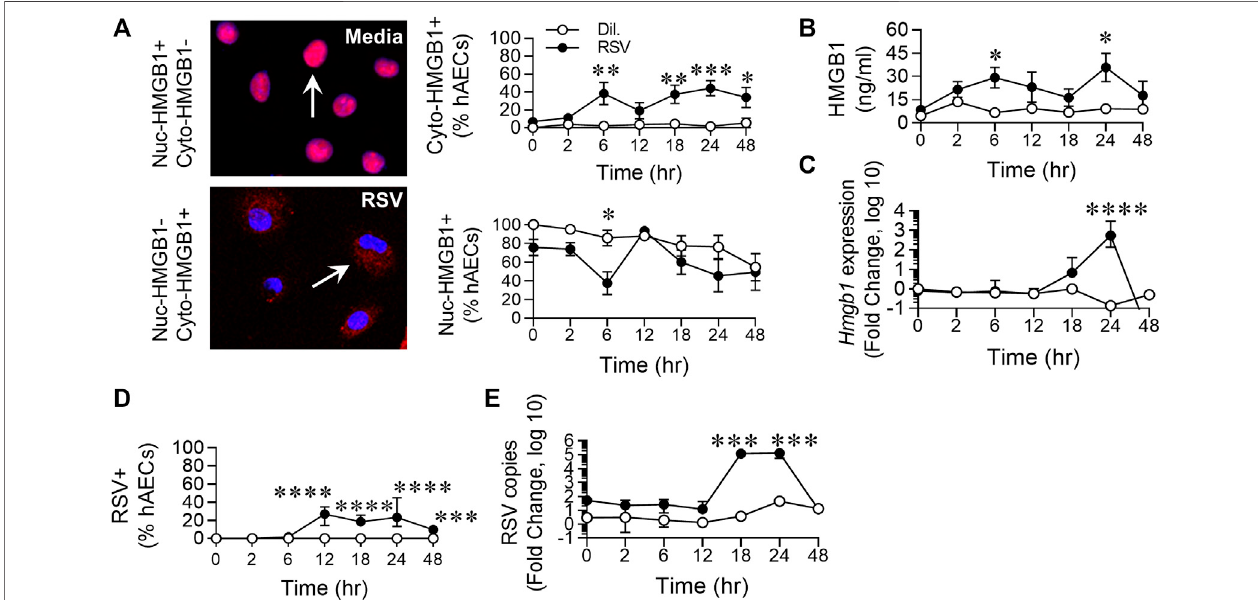
FIGURE 2 | RSV infection of hAECs induces the biphasic release of HMGB1. hAECs were inoculated with RSV (MOI of 1) and the cells analysed at 0, 2, 6, 12, 18, 24, and 48 h post infection (hpi). (A) Quanti fi cation and representative images (magni fi cation ×20) of nuclear- and cytoplasmic-HMGB1 positive hAECs. (B) HMGB1 levels in the cell culture supernatant. (C) HMGB1 gene expression normalized to the house-keeping gene. (D) Quanti fi cation of RSV positive hAECs. (E) Number of viral copies(expression of RSV Ngene) normalized toa house-keeping gene. Each data point represents4-6 donors. The data are presented as the mean ± SEM. The data were analyzed using a two-way ANOVA and Sidak ’ s multiple comparisons test. * p < 0.05, ** p < 0.01, *** p < 0.005, denotes signi fi cance between infected and uninfected cells at the speci fi ed time point.